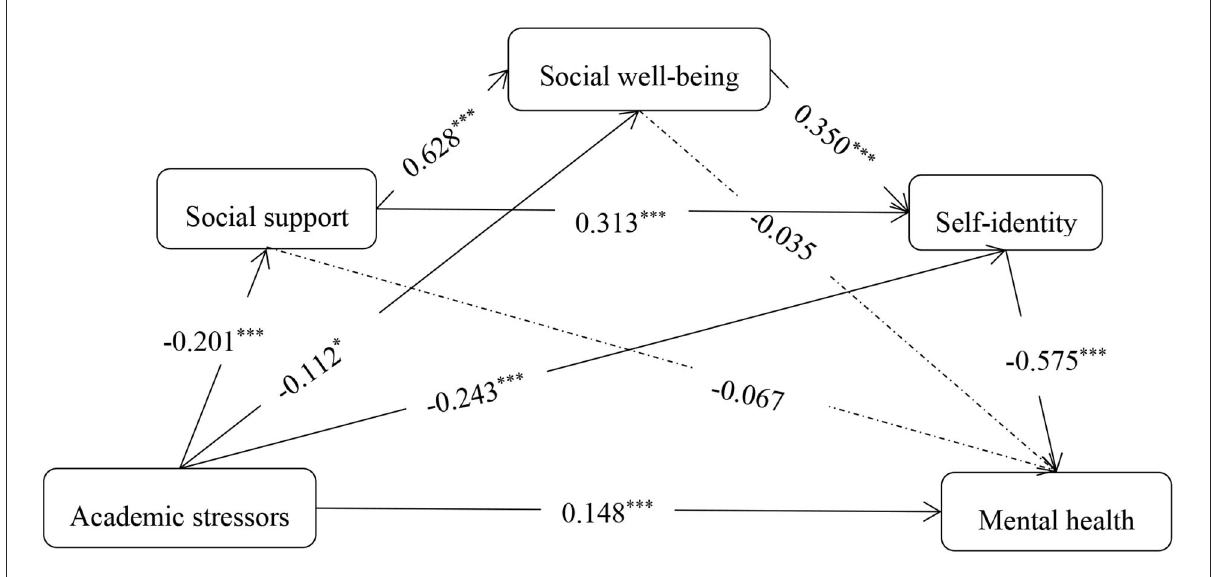
FIGURE2 The mediation model of college students’ academic stressors on mental health. * p < 0.05, *** p < 0.001.